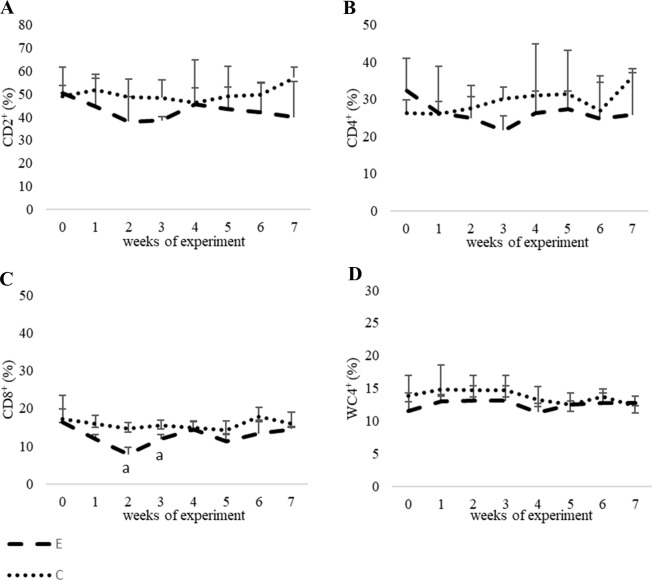
The results of examination of the percentage of lymphocyte subpopulations in peripheral blood of calves (%) ± SD.4A CD2+; 4B CD4+; 4C CD8+; 4D WC4+ ± SD; E–experimental calves; C–control calves. a–a value with this letter differs significantly (P<0.05).